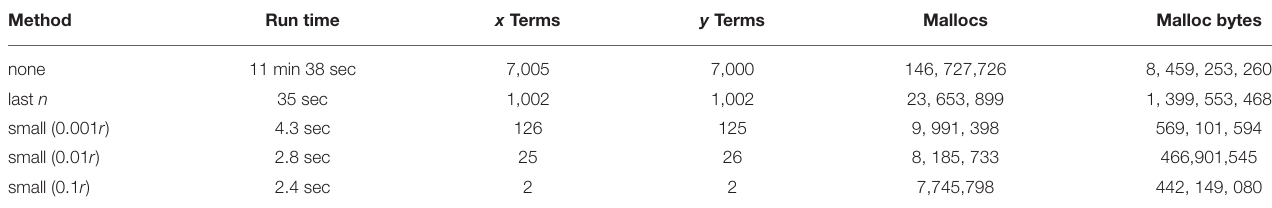
TABLE 1 | Performance comparison of deviation term condensing functions.